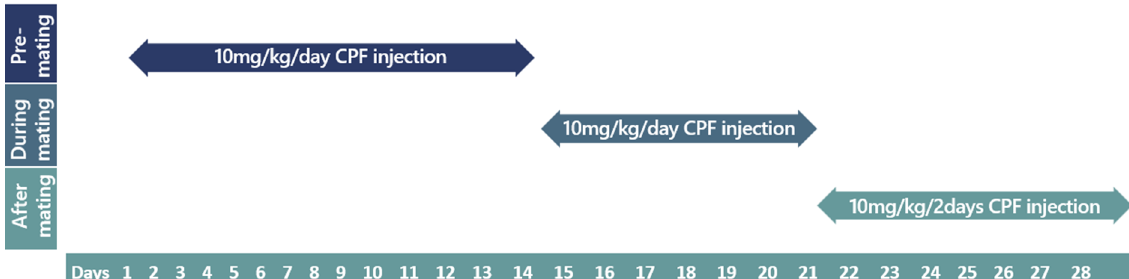
Figure 6. Paternal exposure to chlorpyrifos timeline. Timeline displaying chlorpyrifos exposure doses and periods of male chickens in the paternal exposure group. CPF: chlorpyrifos.